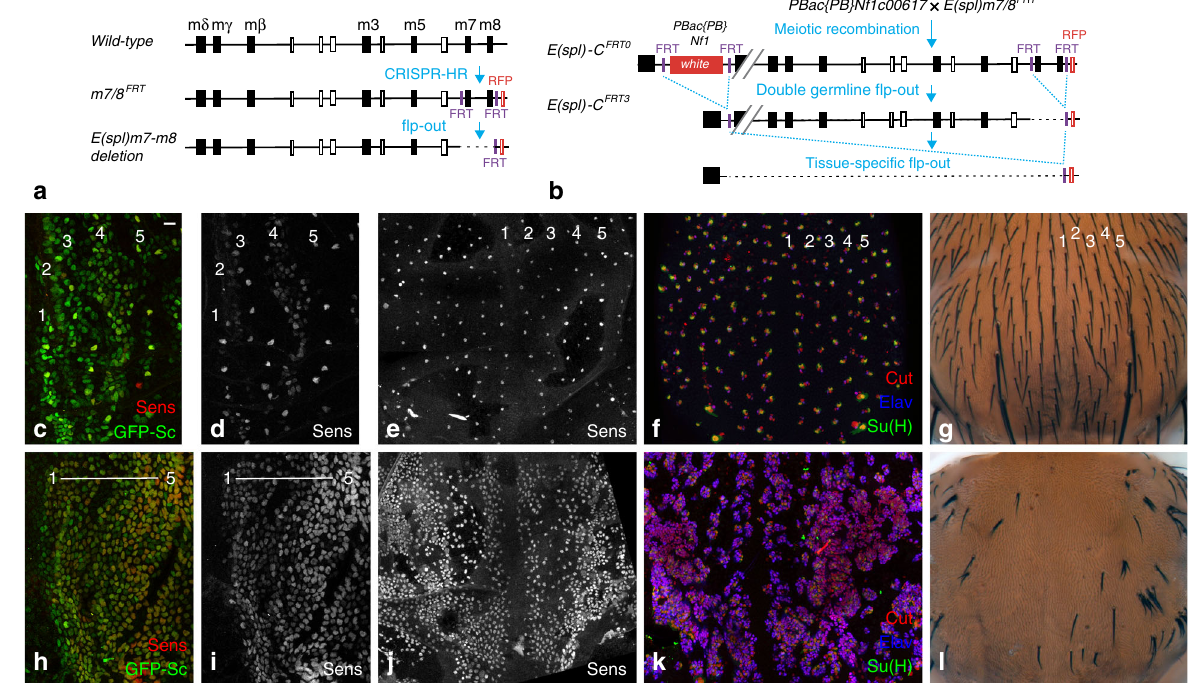
Fig. 2 the E(spl)-C genes mediate the negative template activity of Notch. a Two FRT sites fl anking the m7 and m8 genes were inserted by CRISPR-mediated HR to generate the m7/8 FRT chromosome. A small E(spl)m7-m8 deletion was then generated by fl p-out. b Tissue-speci fi c knock-out of the E(spl)-C . Recombination between a FRT located within a PiggyBac element inserted into the Nf1 gene (marked by white + ) and the FRT sites of the m7/8 FRT chromosome (marked by RFP ) produced the E(spl)-C FRT0 chromosome. Flp-mediated deletion of the white marker, leaving a single proximal FRT, and of the m7 and m8 genes, leaving a single distal FRT, produced the E(spl)-C) FRT3 chromosome which was used for tissue-speci fi c fl p-out to produce a 55 kb E(spl)-C deletion. c – l Sensory organ development was studied in control ( c – g ; + / E(spl)-C FRT3 ap ts > fl p pupae) and deletion nota ( h – l ; Df(3)P11 / E(spl)-C FRT3 ap ts > fl p pupae). At 7 h apf, GFP-Sc (green) and Sens (red) were expressed in a pattern of fi ve proneural stripes in control pupae ( c , d ), similarly as in wild-type pupae (Fig. 1g) whereas nearly all notum cells expressed GFP-Sc and Sens upon conditional knock-out ( h , i ). Thus, the E(spl)-C genes are required for the patterning of the proneural stripes. Regular rows of SOPs ( e , 15 h apf) and sensory bristles ( f , 24 h apf; Elav, blue, is a neuronal marker; Cut, red, marks all sensory cells; Su(H), green, marks the socket cells; g, adult notum) were seen in control fl ies. In contrast, too many SOPs (j, 15 h apf) produced mostly positive neurons (k, 24 h apf), hence leading to a strong bristle loss phenotype ( l ) upon notum-speci fi c deletion of the E(spl)-C . These Notch -like phenotypes indicate that the E(spl)-C genes are key Notch targets for the formation of sensory organs. Scale bar is 10 μ m ( c : c – l